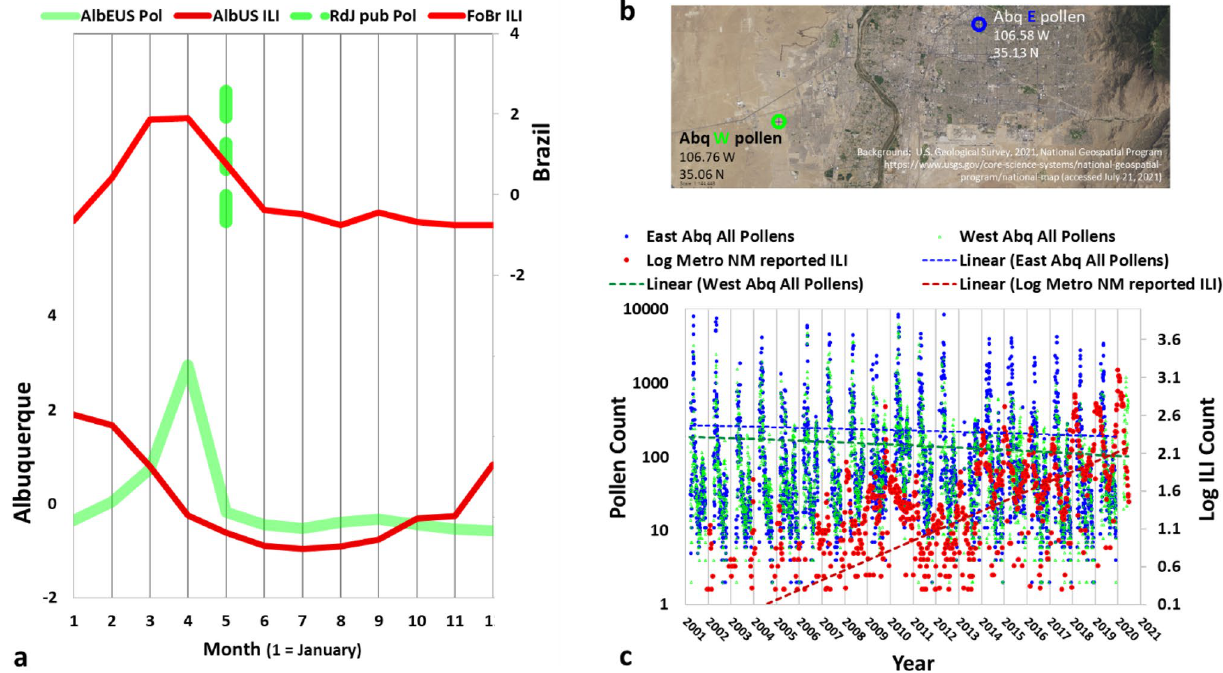
Figure 2. ( a ) Average monthly (climatological) patterns for ILI (red) and pollen (green) for Brazil (top) and Albuquerque, US (bottom). The data are averaged from 2001 to the present. The dotted green line, indicating the occurrence of pollen peak, is based on Greco et al 29 . The solid lines are based on data from Tamerius et al. 23 for Brazil ILI and NMDOH 30 for Albuquerque ILI (both red) and from CABQ 31 for pollen (green). ( b ) Locations of Albuquerque pollen monitor stations. ( c ) Comparison of reported ILIs to records of two pollen monitoring stations for Albuquerque, NM, US. Sources ILI 30 pollen 31 .